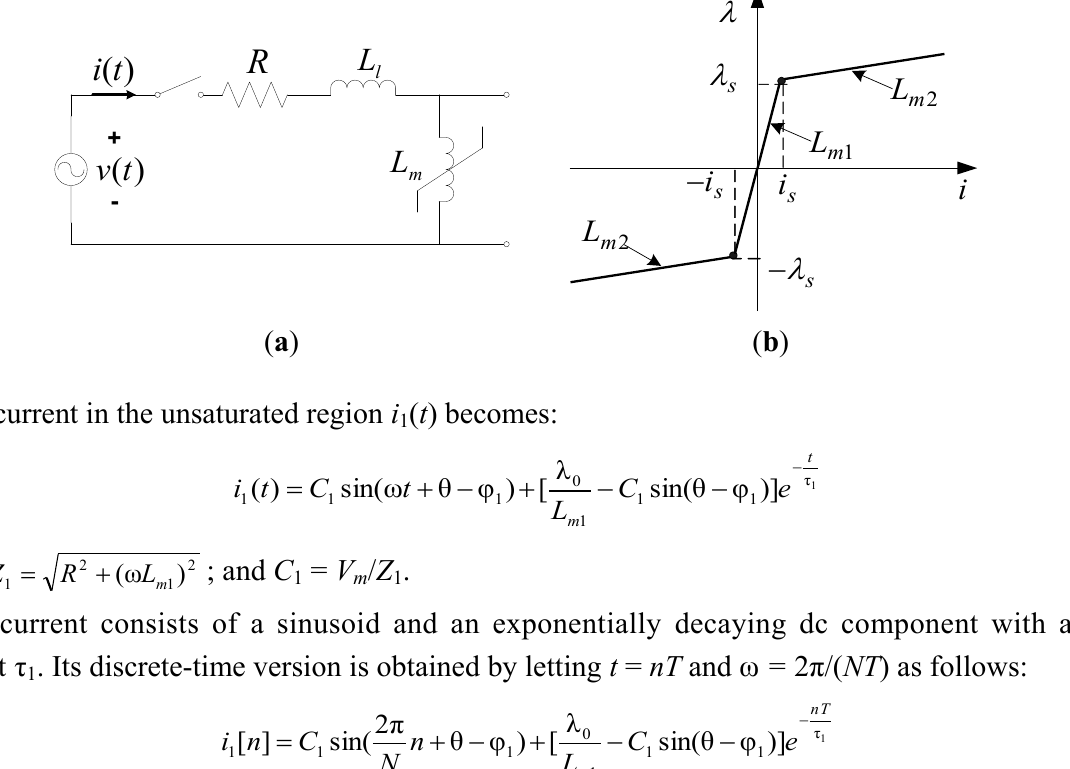
: magnetising current at the s